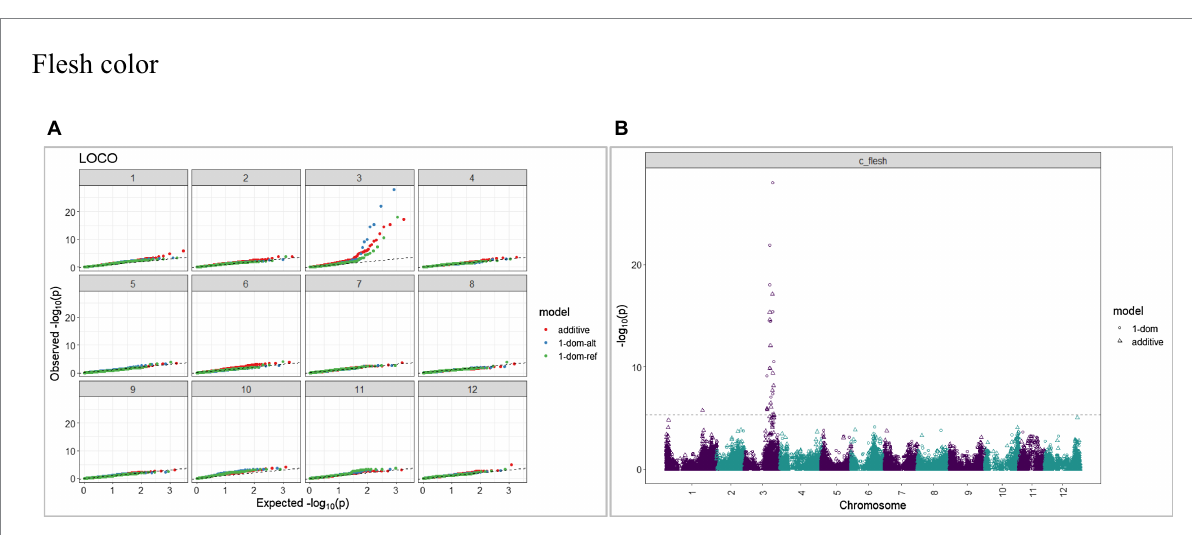
FIGURE 9 Q–Q plots of observed vs. expected -log10 ( p values) ( A ) and corresponding Manhattan plot (B) for intensity (chroma value) of flesh color using the additive and dominant model for tuber traits of 214 potato clones evaluated in three environments in Texas: Dalhart 2019, 2020 and Springlake 2020. The Bonferroni threshold was at 5.3 for the additive, 5.0 for 1-dom-alt, and 5.1 for the 1-dom-ref